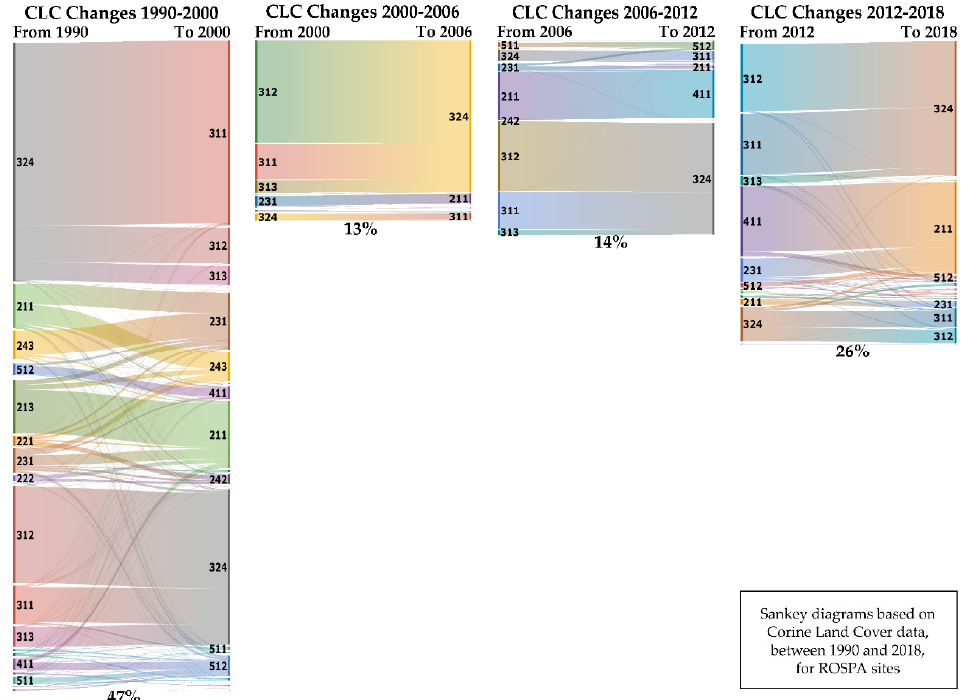
Figure 6. CLC dynamics within ROSPA sites (1990-2018).